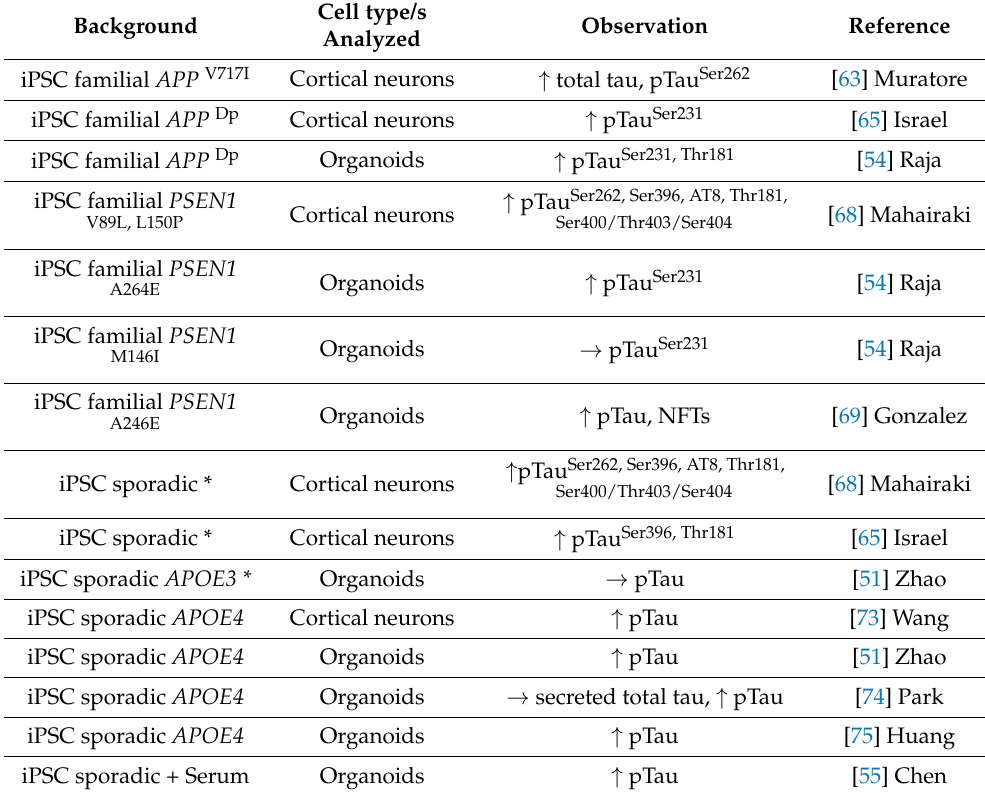
Table 2. Overview of tau pathology modelled in AD-iPSCs harboring either familial mutations, sporadic mutations or from late-onset sporadic AD